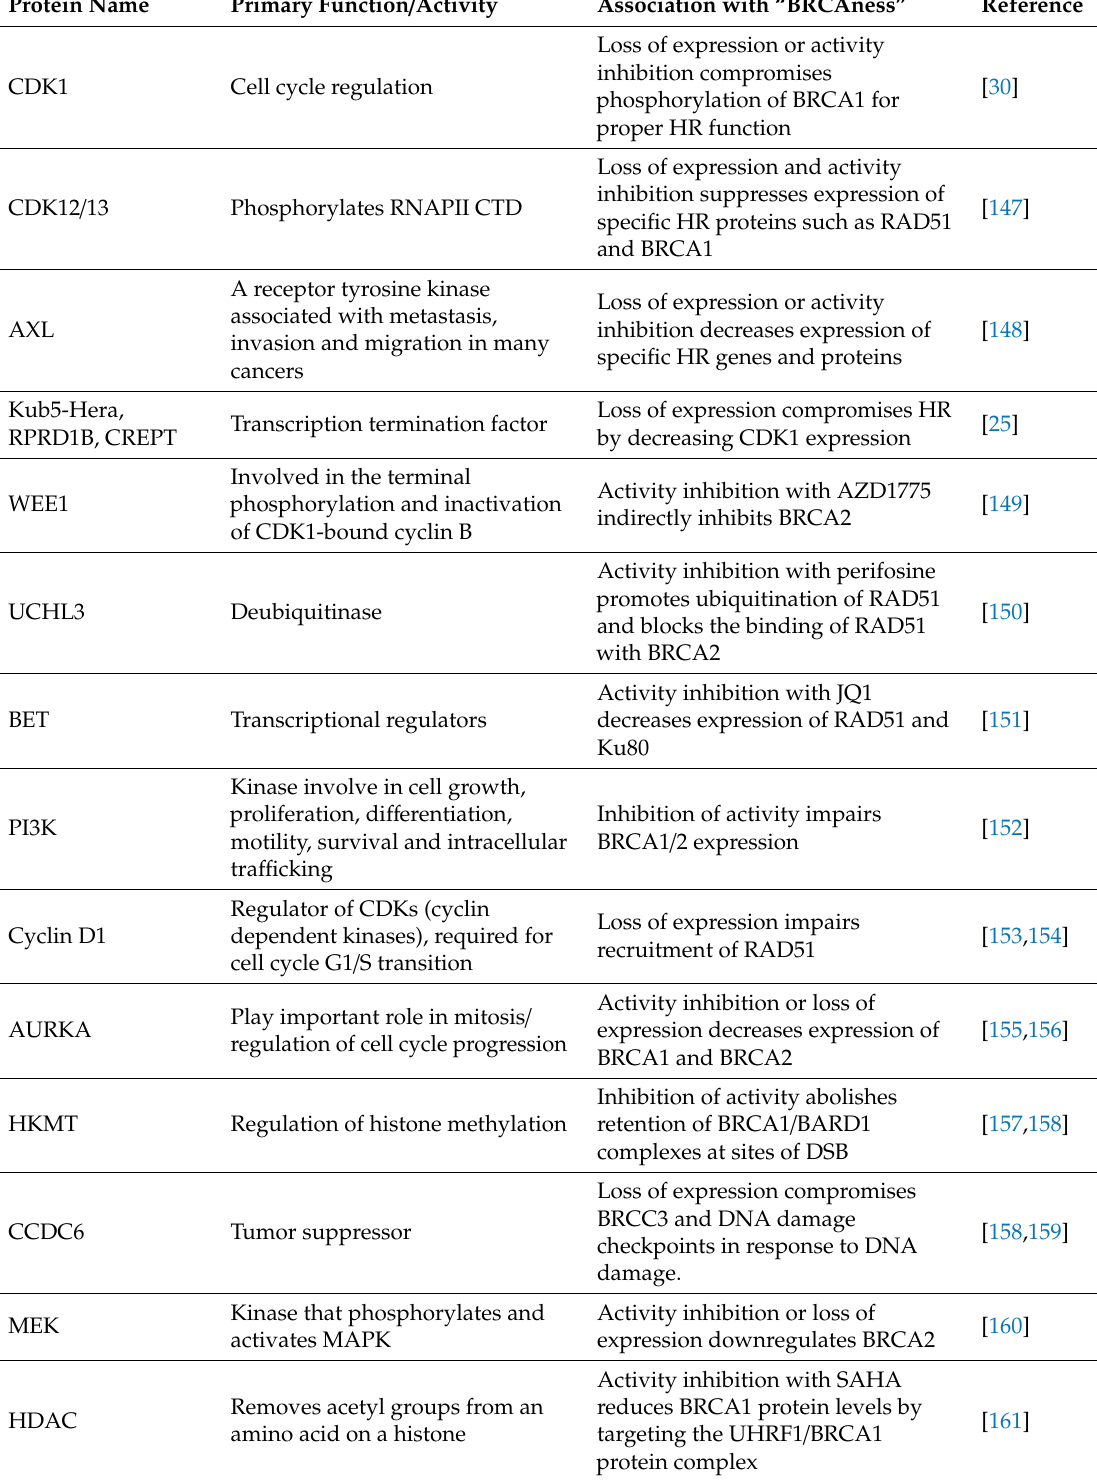
Table 1. Representative list of genes / proteins that have been shown to cause “BRCAness” or HR defect in BRCA-proficient tumors when expression is lost or activity is inhibited. These deficiencies could be exploited as predictive biomarkers for precision treatment with PARP